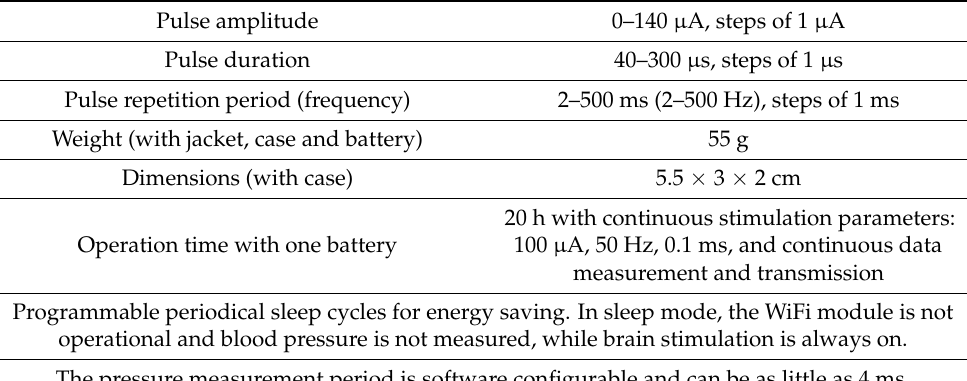
Table 1. Summary of the device parameters and features.